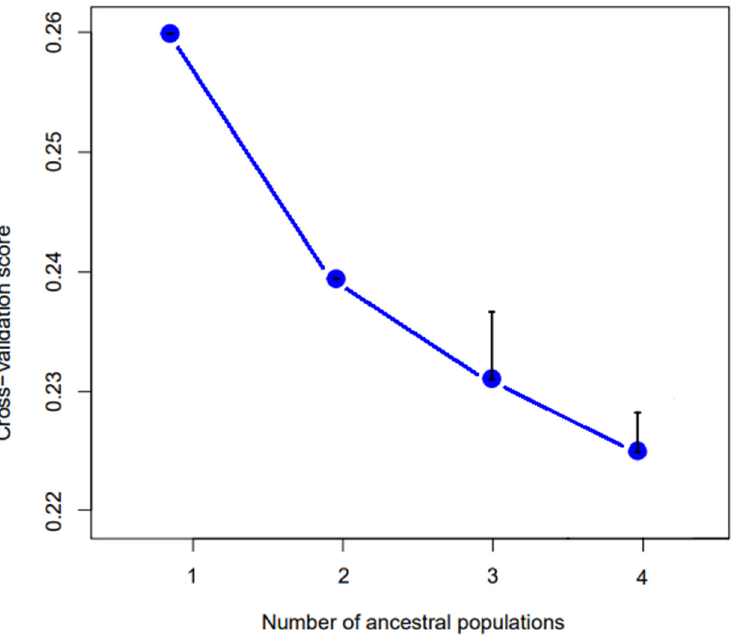
Figure 9. Cross-validation scores for k from 1 to 4. The lower the CV-score, the better fitting is the number of ancestral populations. k = 4 is the best fitting value. Black bars represent the estimated error.